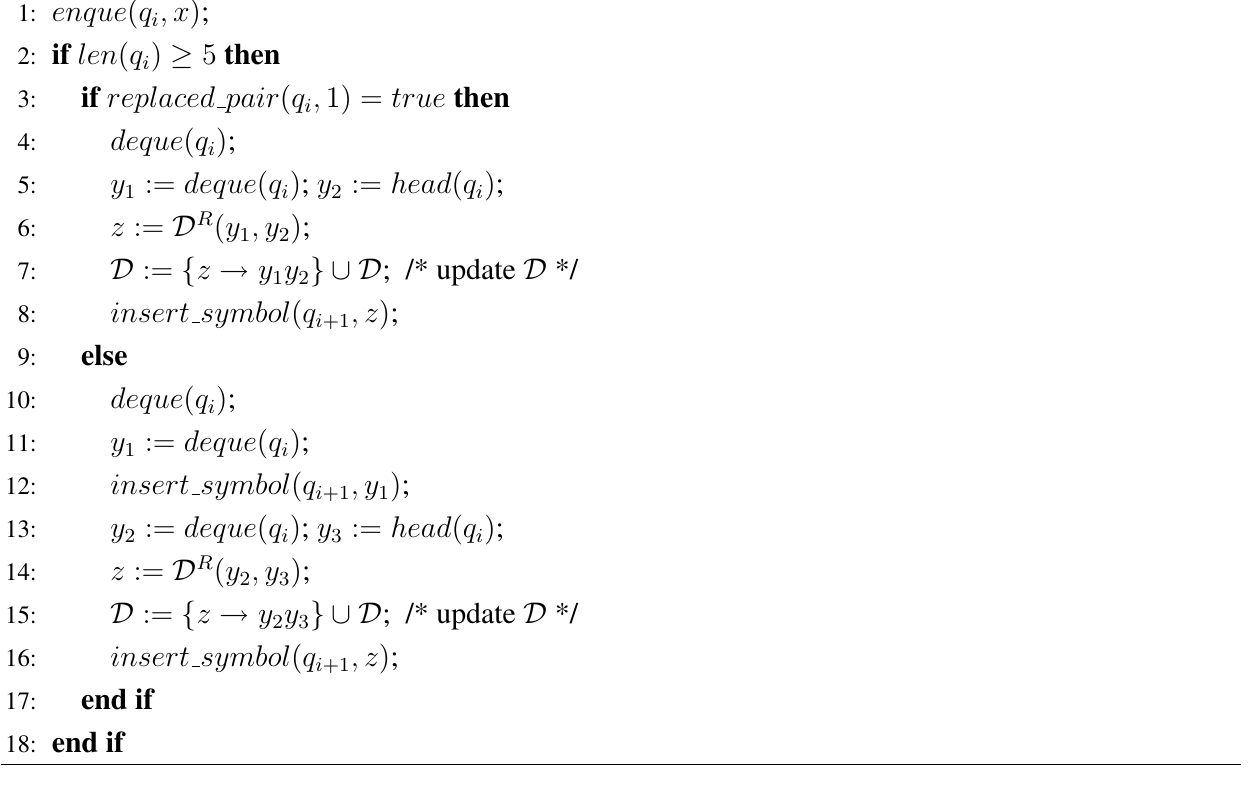
Figure 4. The action of insert symbol ( q